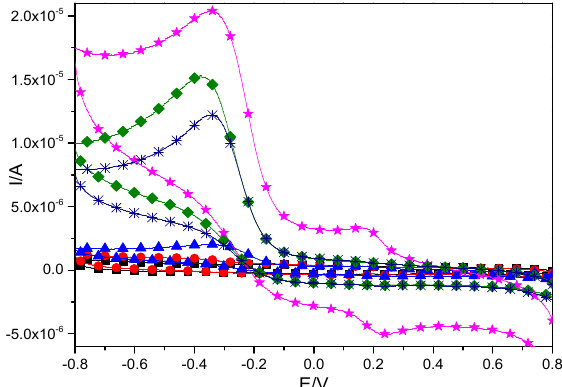
Figure 5. Cyclic voltammograms of the control electrodes and the CTS-CAT/ β -CD-FE composite electrode in different solutions. ■ : The bare electrode in 0.1 mol/L PBS (pH = 7.0) at 0.1 mol/L H 2 O 2 ; ● : The control electrode B in 0.1 mol/L PBS (pH = 7.0) at 0.1 mol/L H 2 O 2 ; ▲ : CTS-CAT/ β -CD-FE composite electrode in 0.1 mol/L PBS (PH = 7.0); ★ : CTS-CAT/ β -CD-FE composite electrode in 0.1 mol/L PBS (pH = 7.0) at 0.1 mol/L H 2 O 2 ; ◆ : The control electrode A in 0.1 mol/L PBS (pH = 7.0) in 0.1 mol/L H 2 O 2 ; ✳ ： Control electrode A in 0.1 mol/L PBS (pH = 7.0).